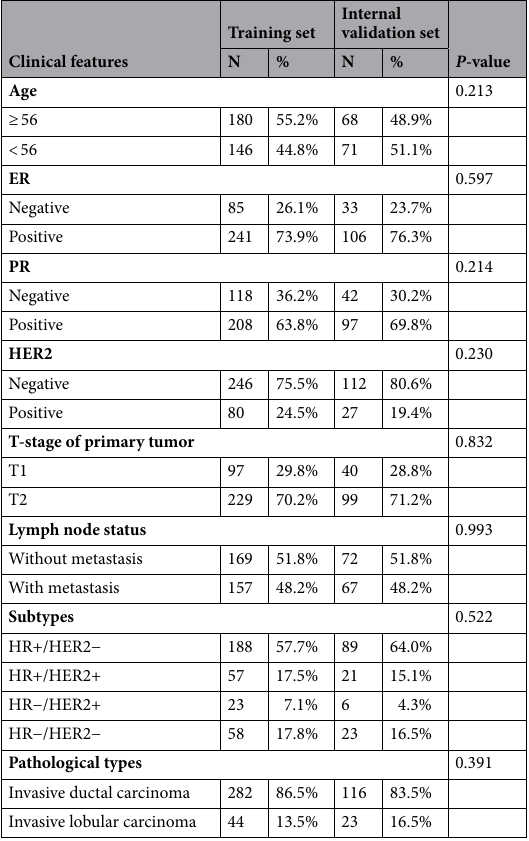
Table 1. Baseline characteristics of samples from the TCGA